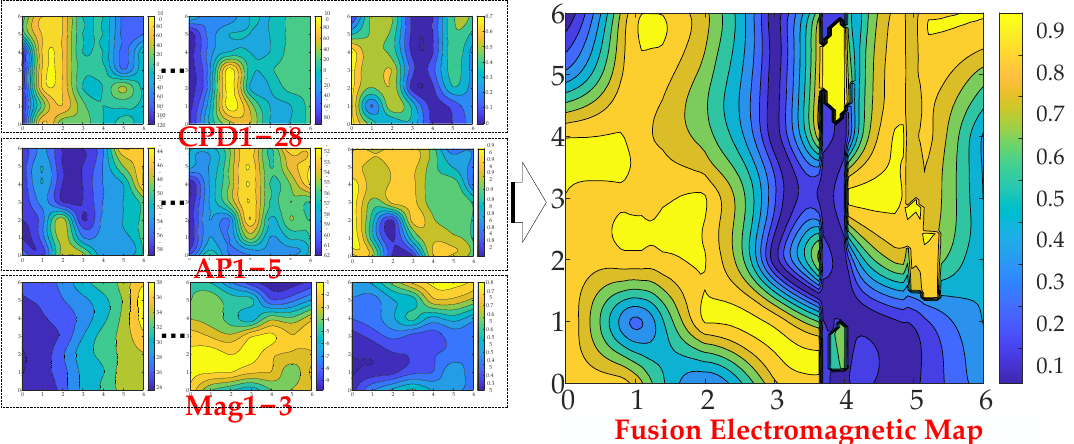
Figure 15. Construction of multi-dimensional atlas dataset.